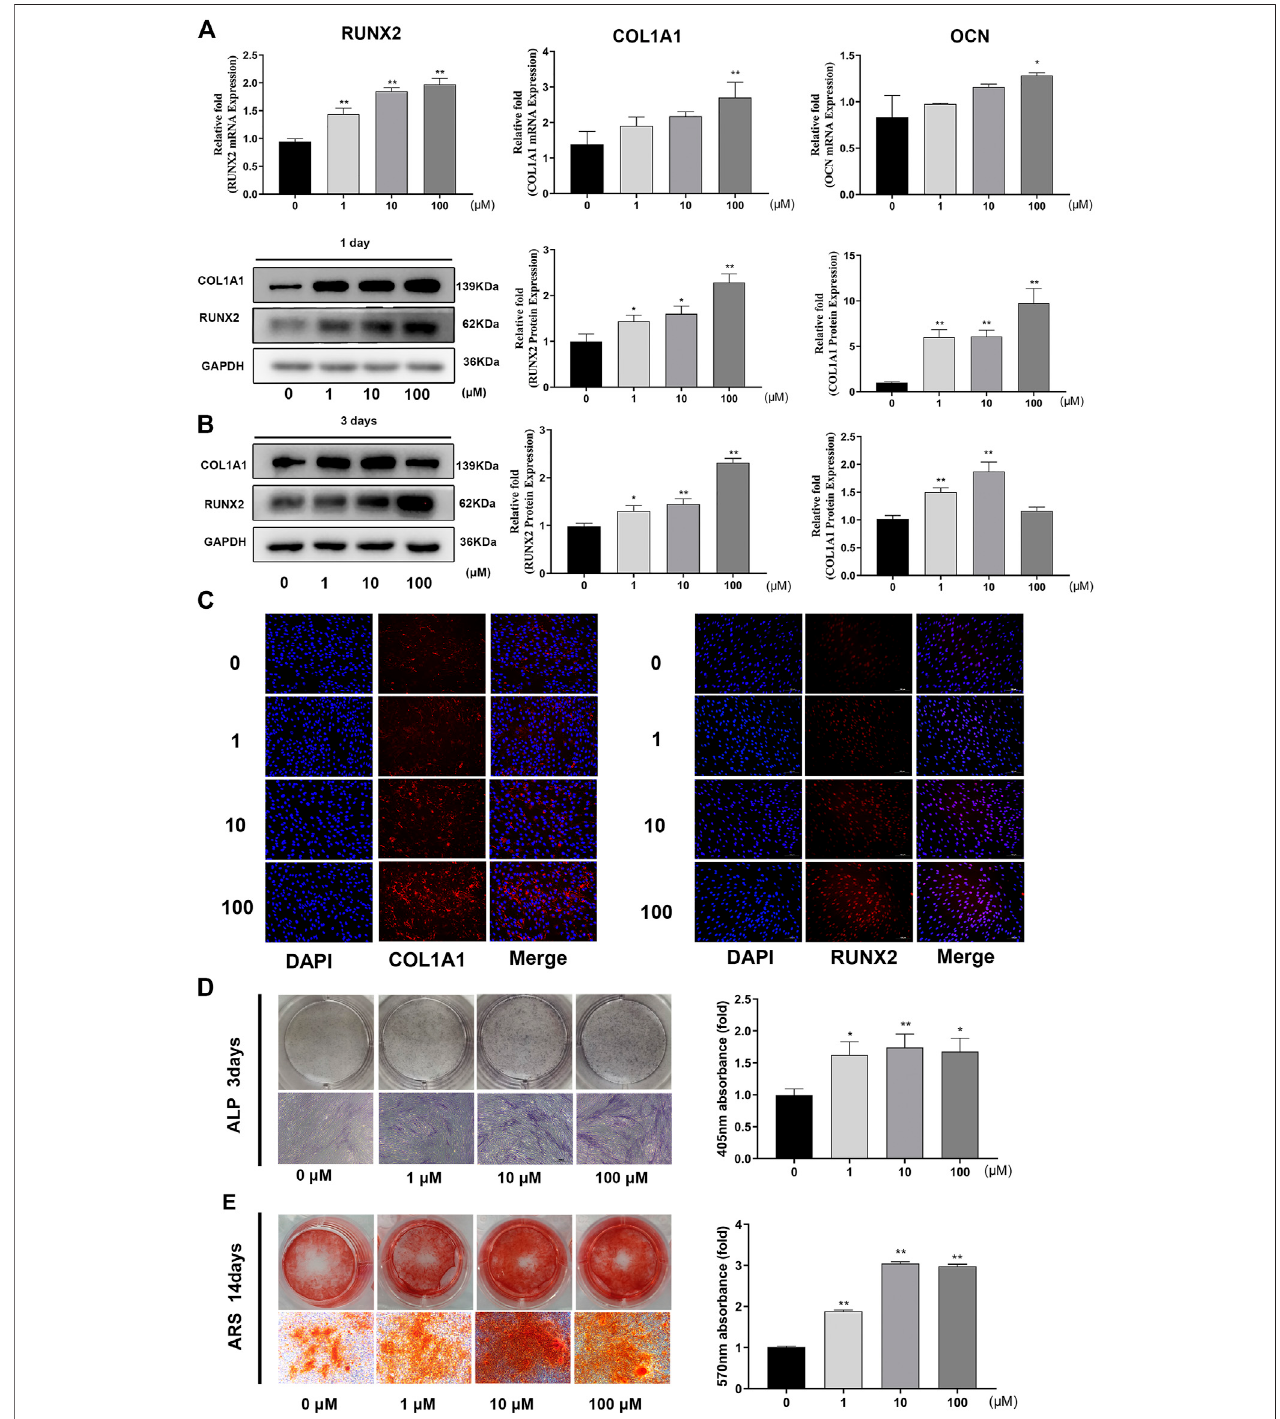
FIGURE 2 | GA increased the expression levels of osteo-speci fi c genes and proteins and enhanced calcium deposition. (A) Relative mRNA expression of osteo- relatedgenes(RUNX2,COL1A1andOCN)measured byrealtimequantitative PCRafter 1dayofosteogenesis.ThemRNAexpression levelswerenormalized relativeto that of GAPDH RNA. (B) Relative protein expression levels of osteo-related protein (RUNX2 and COL1A1) were measured by western blotting after 1 and 3 days of osteogenesis. The protein expression levels were normalized relative to that of GAPDH protein. (C) Immuno fl uorescence staining for COL1A1 and RUNX2 protein after1dayofosteogenesis.Scalebars,100 μ m. (D) ALPstainingandquantitativeassayonday3ofosteogenicdifferentiation.Scalebar,500 μ m. (E) Mineralizationwas measuredbyARSstainingandquantitativeassayafter14daysofosteogenesis.Scarbar,500 μ m.Alldataareexpressedasthemeans ± SD.Reactionswereperformed in triplicate. * p < 0.05, ** p < 0.01 compared to the control group.